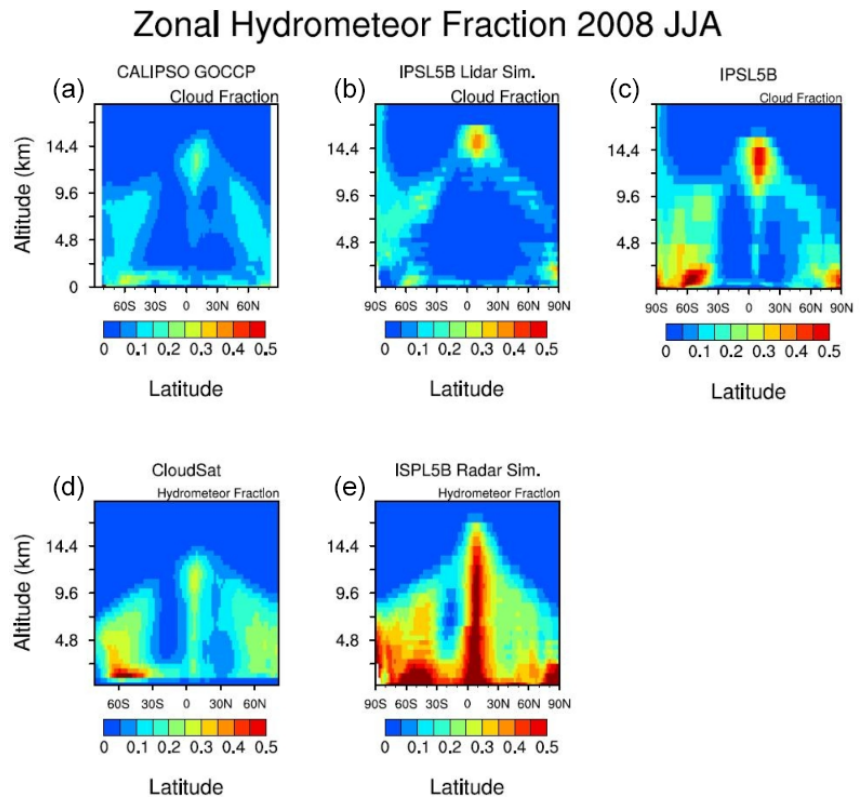
Figure 6. Zonal cloud and hydrometeor fraction for JJA 2007. Cloud fraction (top row): (a) CALIPSO-GOCCP data, (b) IPSL5B with the CALIPSO simulator, and (c) the IPSL5B cloud fraction. Hydrometeor fraction (bottom row): (d) CloudSat data; (e) IPSL5B with the CloudSat simulator. Produced for IPSL5B with the observational data used in Nam and Quaas (2012), ©American Meteorological Society. Used with